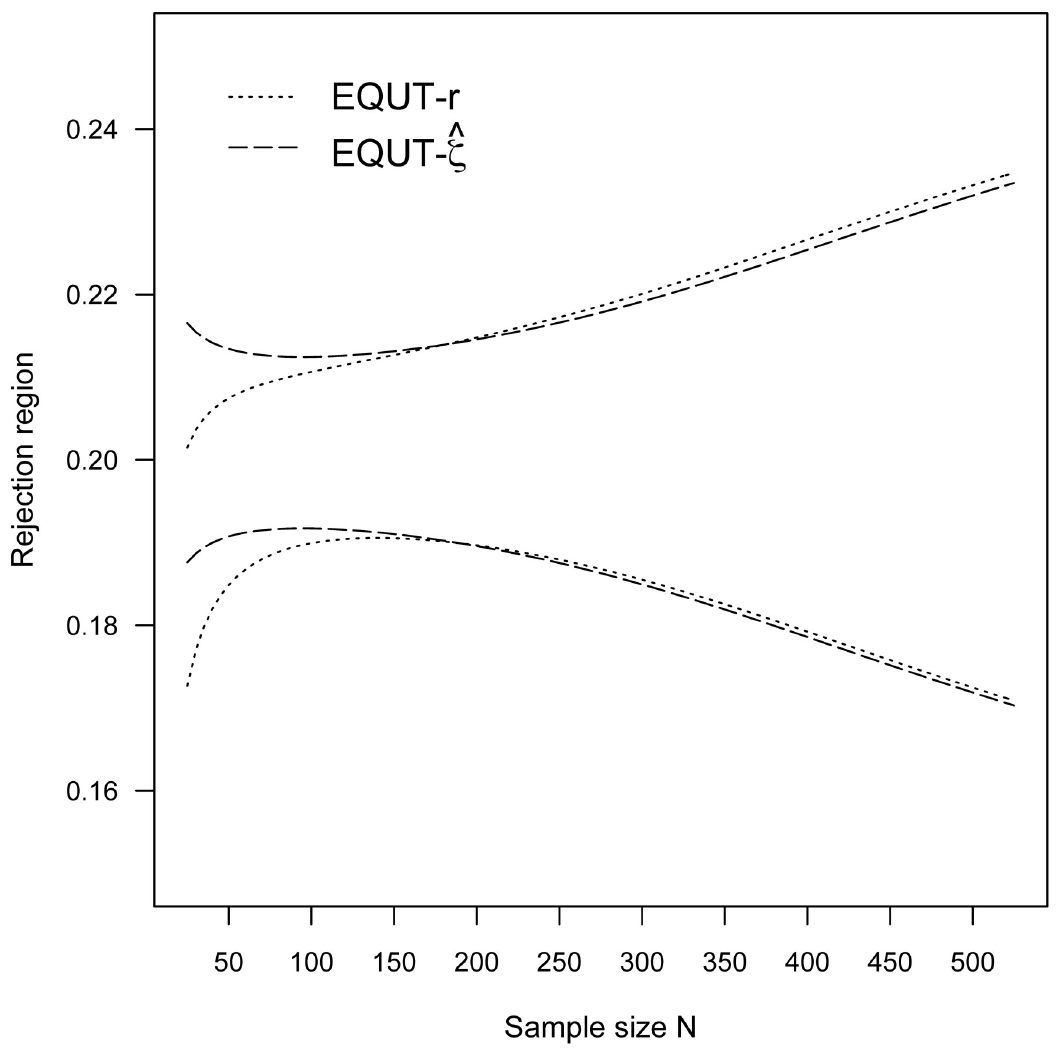
Fig 2. The rejection regions for ( ρ